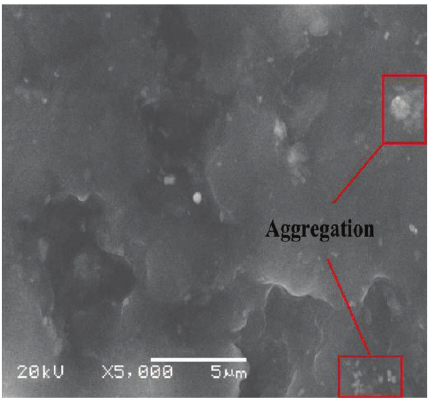
Figure 1: Aggregations and uneven distribution of nanoparticles in matrix.